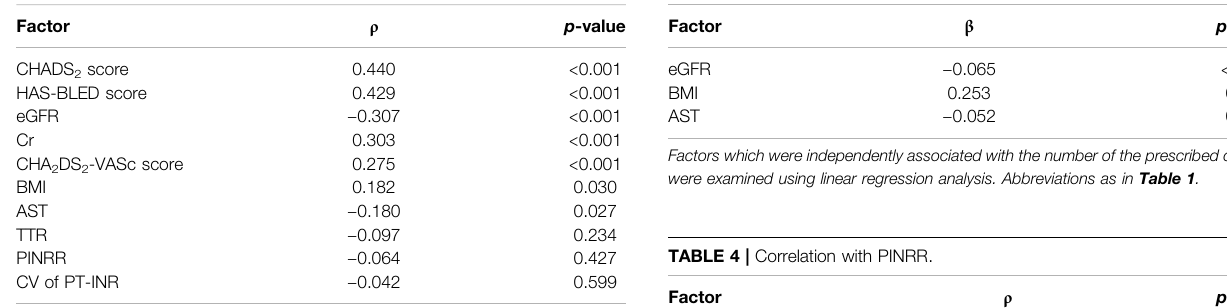
TABLE 3 | Multivariate factors associated with the number of the prescribed drugs.